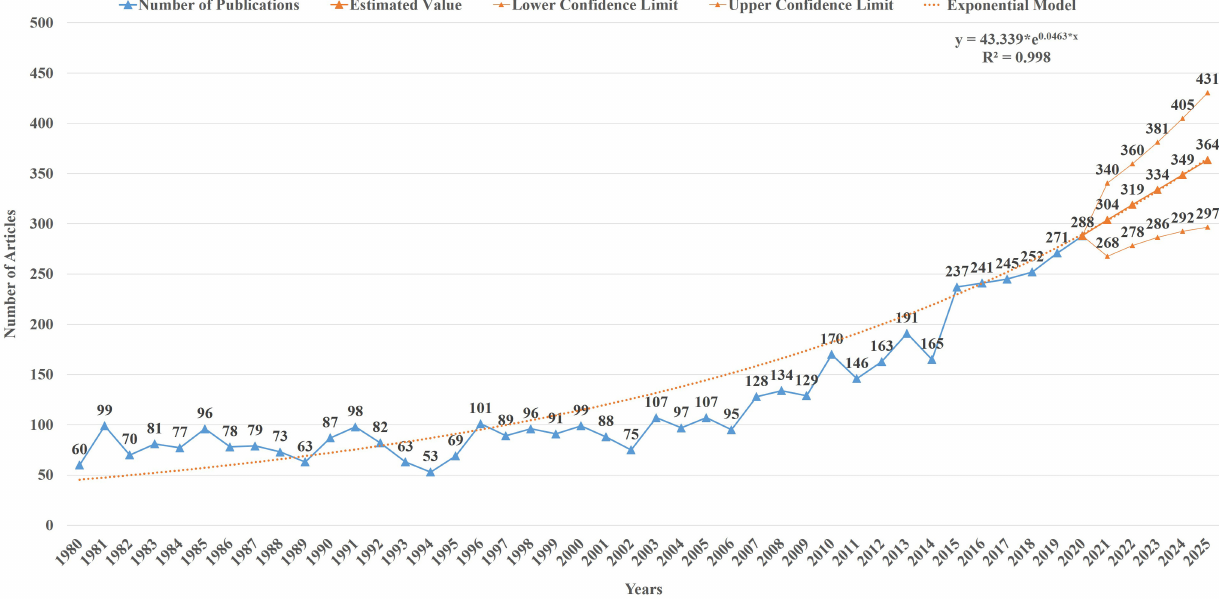
Figure 1. Number of articles published on gastrointestinal bleeding by years and estimation of the number of articles that will be published in the